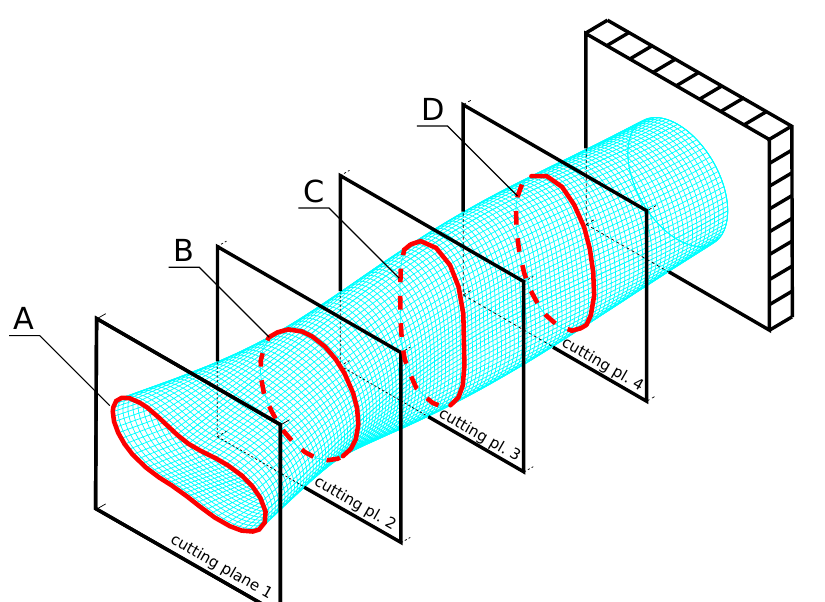
Figure 4. Selection of four FE model cross-sections for mode shape